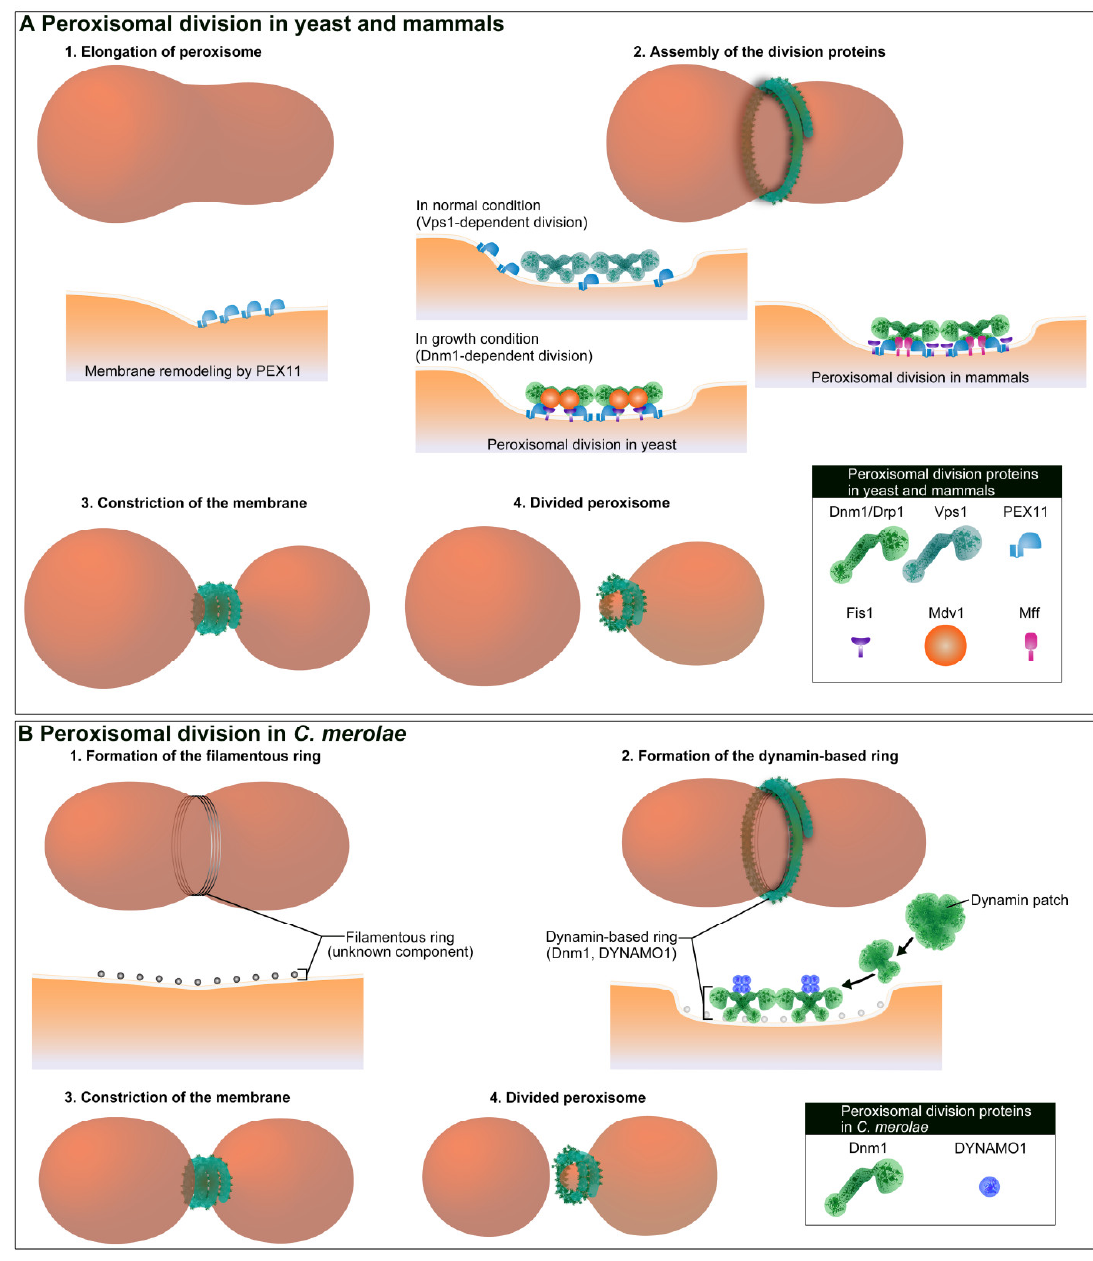
Figure 2. Peroxisomes are divided by Dnm1 / Drp1-based membrane fission machinery. ( A ) Peroxisomal division in yeast and mammals are initiated by PEX11. In yeast S. cerevisiae , Vps1 and PEX11 are involved in the peroxisomal division in normal conditions. In growth condition, Dnm1, PEX11, Fis1, and Mdv1 are involved in the division. In mammals, Drp1, PEX11 β , Fis1, and M ff are involved in the division. ( B ) In C. merolae , a peroxisome is divided by peroxisomal-dividing (POD) machinery (filamentous ring and dynamin-based ring). The filamentous ring is thought to be formed first at the division site followed by formation of the dynamin-based ring. Dnm1 is likely recruited from cytosolic dynamin patches. DYNAMO1 regulates both recruitment of Dnm1 and GTP-dependent constriction of dynamin-based ring.